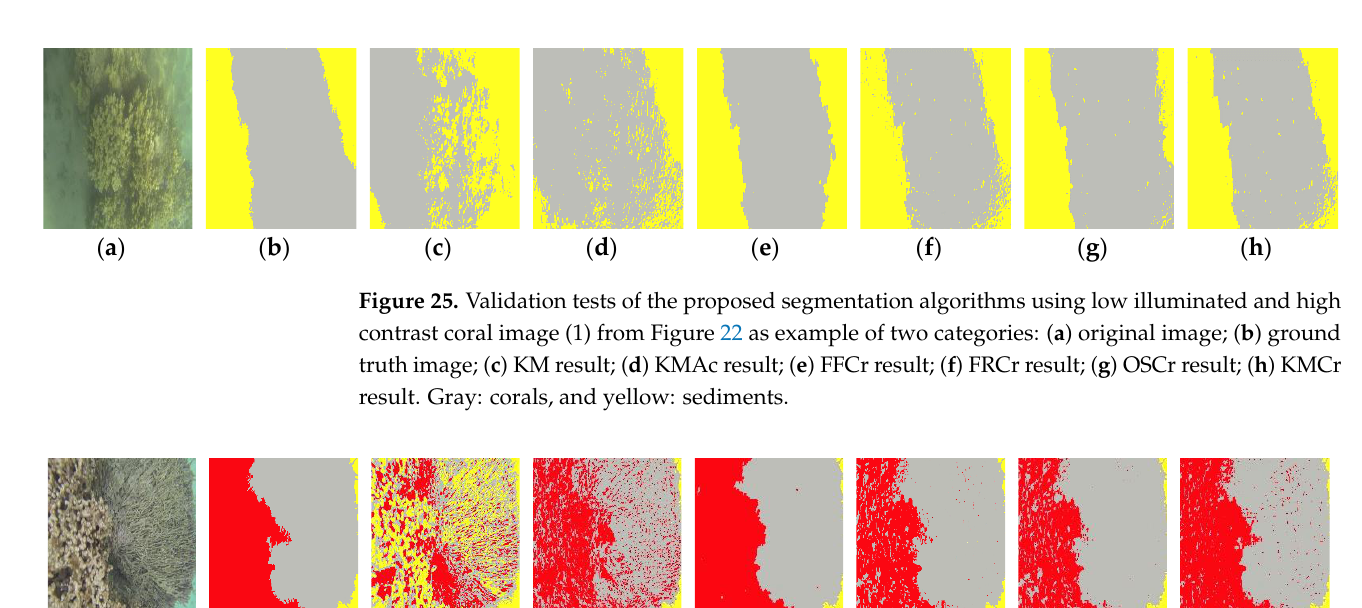
Figure 26. Validation tests of the proposed segmentation algorithms using low illuminated and high contrast coral image (8) from Figure 22 as example of three categories: ( a ) original image; ( b ) ground truth image; ( c ) KM result; ( d ) KMAc result; ( e ) FFCr result; ( f ) FRCr result; ( g ) OSCr result; ( h ) KMCr result. Gray: corals, red: blue corals, and yellow: sediments.